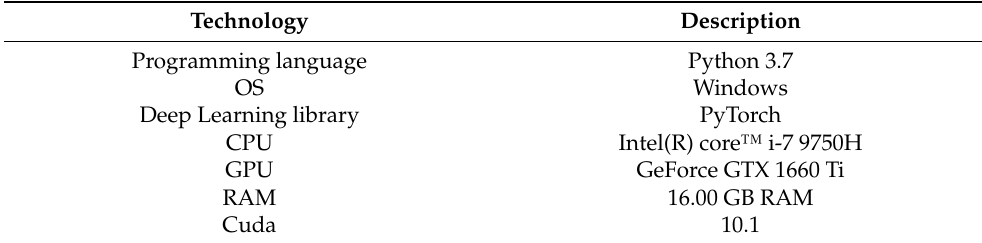
Table 2. Performance hardware and software of